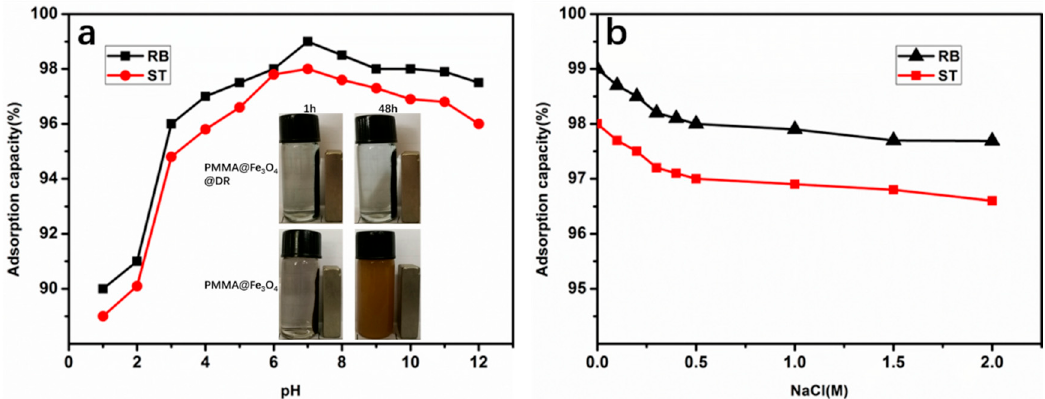
Figure 8. ( a ) Effect of pH on the adsorption of RB and ST by PMMA@Fe 3 O 4 @DR adsorbent at 25 °C and (inset) photographs of PMMA@Fe 3 O 4 @DR and PMMA@Fe 3 O 4 in pH = 1 for 1 and 48 h; ( b ) Effect of ionic strength on the adsorption of RB and ST by PMMA@Fe 3 O 4 @DR at pH 7 and 25 °C. In both a and b, the initial dyes concentrations of RB and ST are 5 mg/mL.